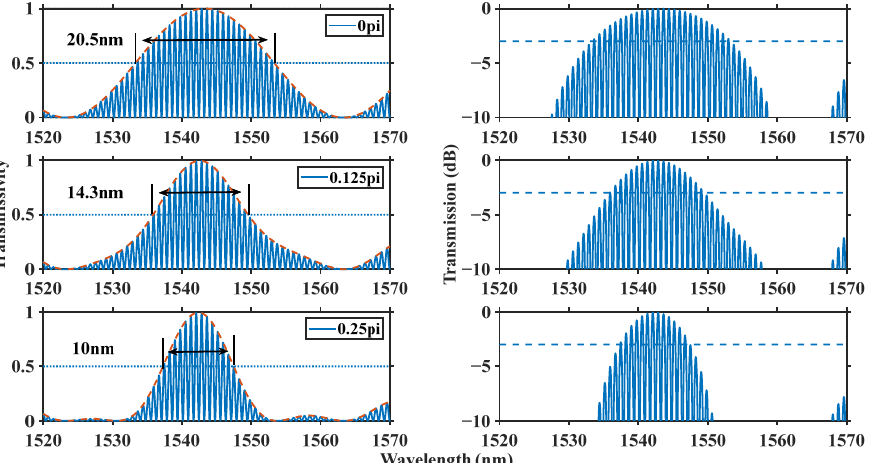
Figure 3. Simulated spectrum of the composite filter with different θ .